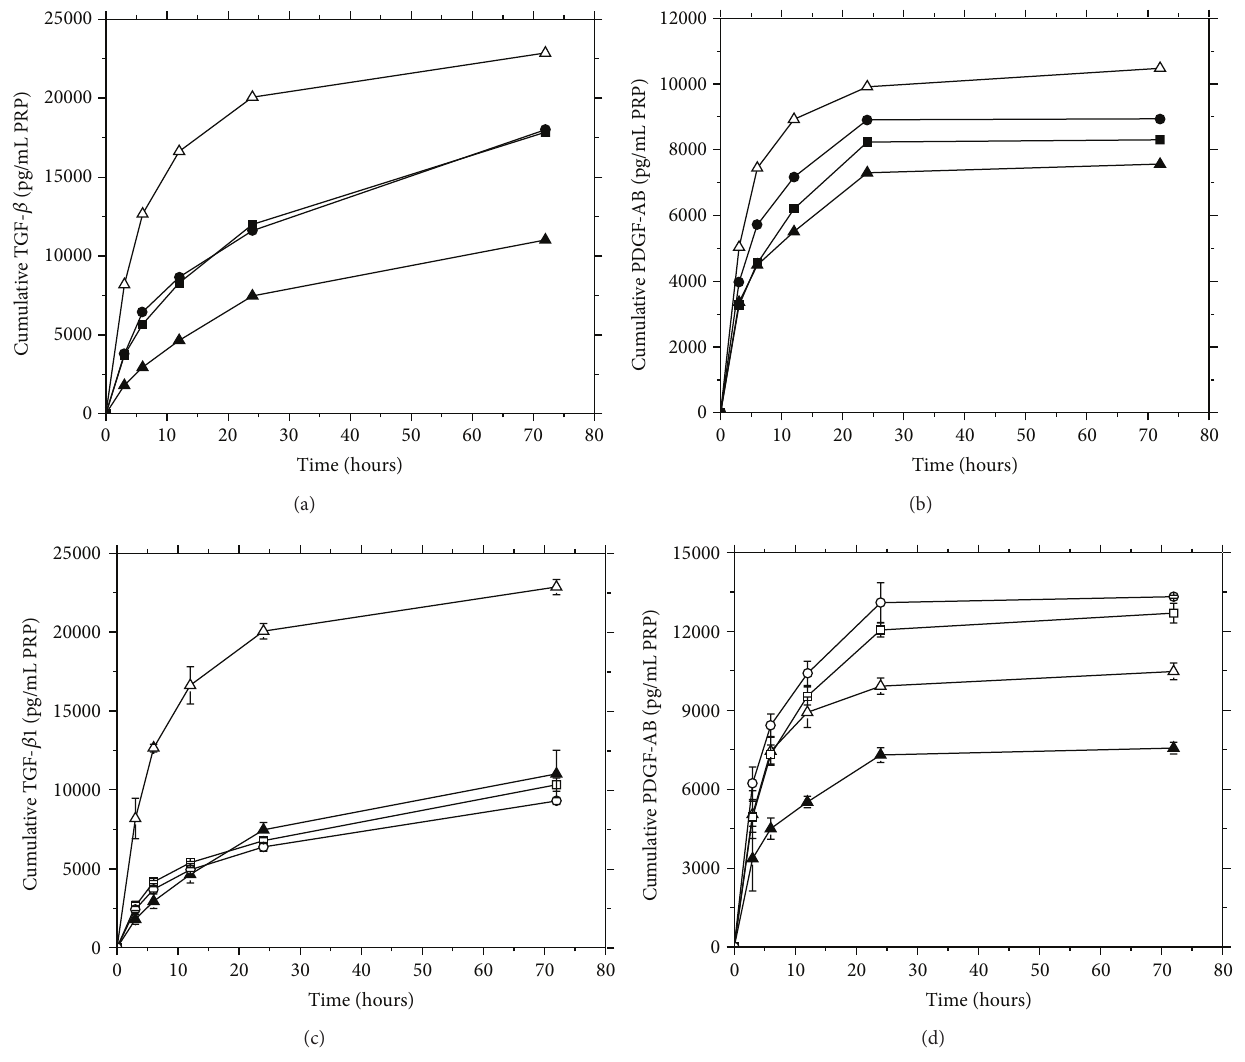
Figure 5: Release profiles of growth factors from 𝑎 P-PRP in porous chitosan scaffolds as a function of ((a), (b)) chitosan concentrations and ((c), (d)) freezing conditions. ( ◼ ) PCHTs 1% ( − 20 ∘ C); ( e ) PCHTs 2% ( − 20 ∘ C); ( 󳵳 ) PCHTs 3% ( − 20 ∘ C); ( ◻ ) PCHTs 3% ( − 80 ∘ C), (O) PCHTs 3% ( − 196 ∘ C), and ( 󳵻 ) P-PRP activated with Ca +2 /thrombin (used as control); TGF- 𝛽 1 ((a), (c)); and PDGF-AB ((b), (d)). The